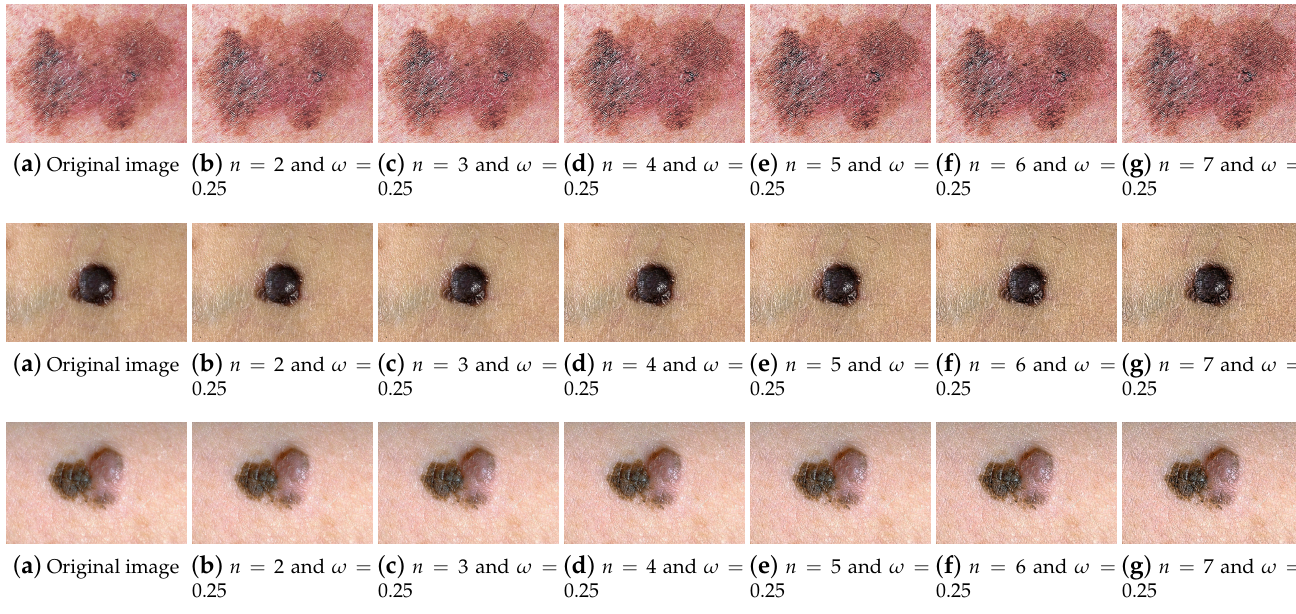
Figure 6. Visual results obtained by MGRTH in the different iterations.